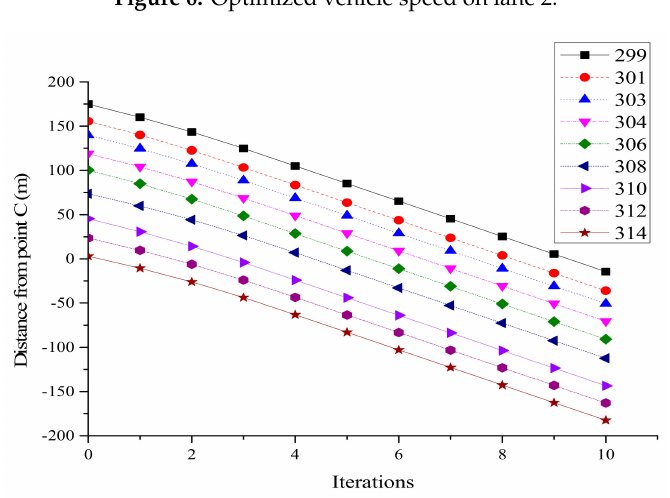
Figure 7. Distance from point C on lane